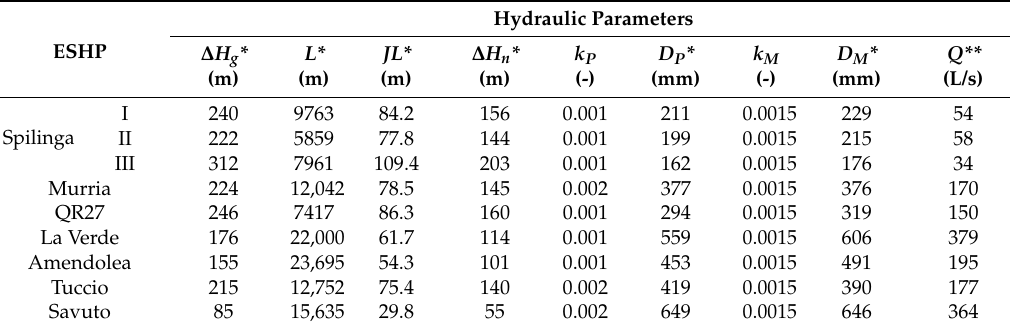
Table 3. Hydraulic parameters calculated by the simplified method for evaluating SHP energy production in seven irrigation systems of Calabria (Southern Italy).